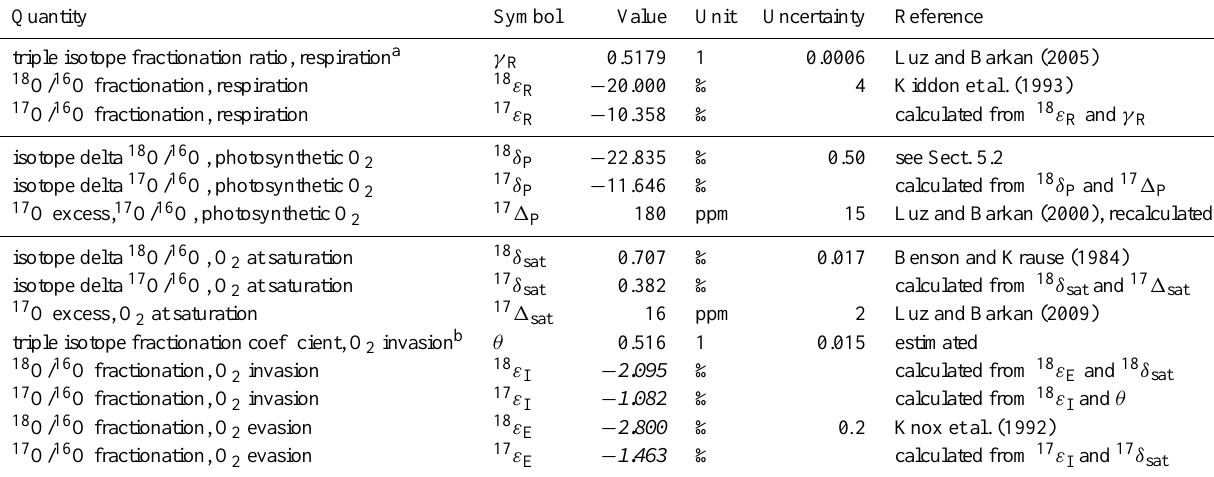
Table 2. Input parameters used as base case in the calculation of g (Sect. 6.1) and their uncertainties (Sect. 5). All δ values are relative to Air-O 2 . The 17 1 values are defined as 17 1 = 17 δ − 0.5179 18 δ (cf. Eq. 8) and expressed relative to Air-O 2 . However, they are not